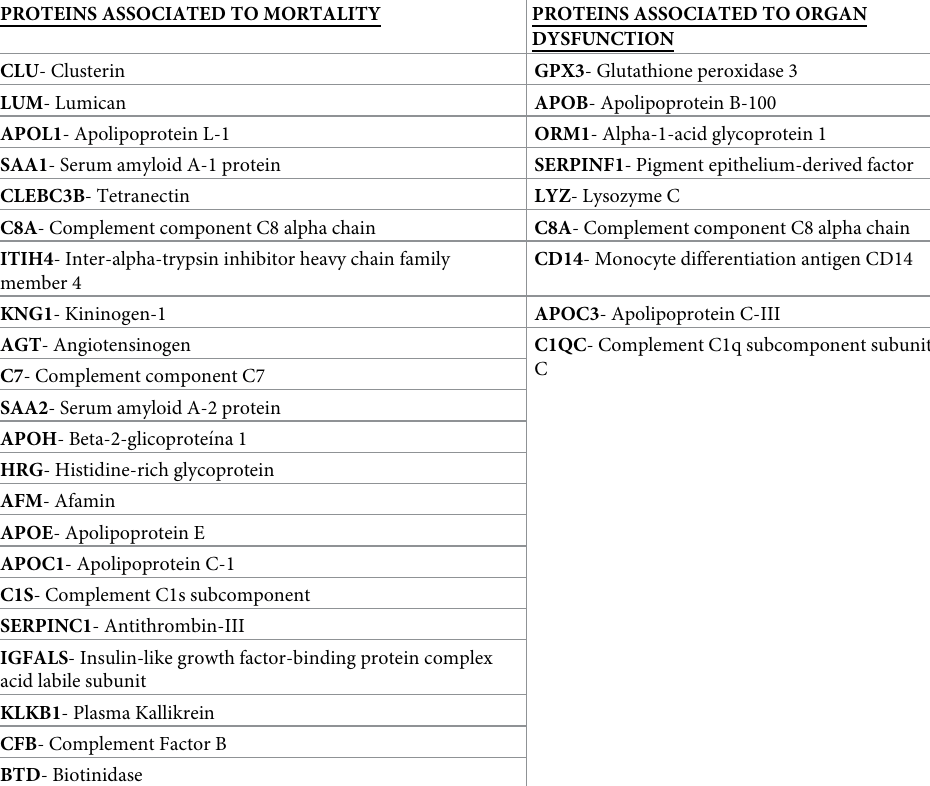
Table 2. Proteins analyzed and their relationship with mortality /organ